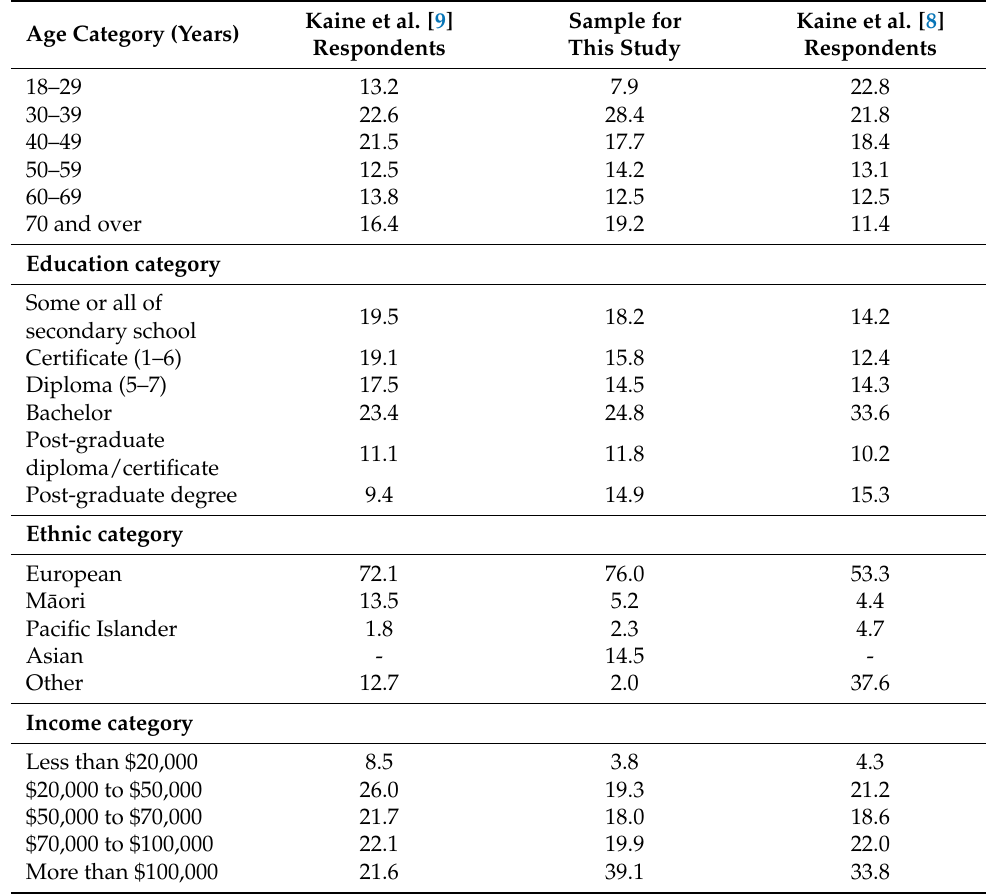
Table 1. Age, education, ethnicity, and income distribution of